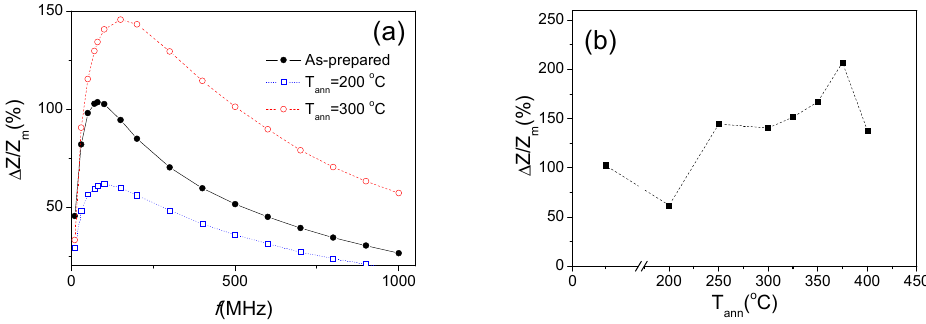
Figure 9. Δ Z/Z m ( f ) dependencies for as-prepared and annealed for 60 min at 200 °C and 300 °C Fe 3.6 Co 69.2 Ni 1 B 12.5 Si 11 Mo 1.5 C 1.2 microwires ( a ) and Δ Z/Z m (T ann ) dependence for Fe 3.6 Co 69.2 Ni 1 B 12.5 Si 11 Mo 1.5 C 1.2 microwires measured at 100 MHz ( b